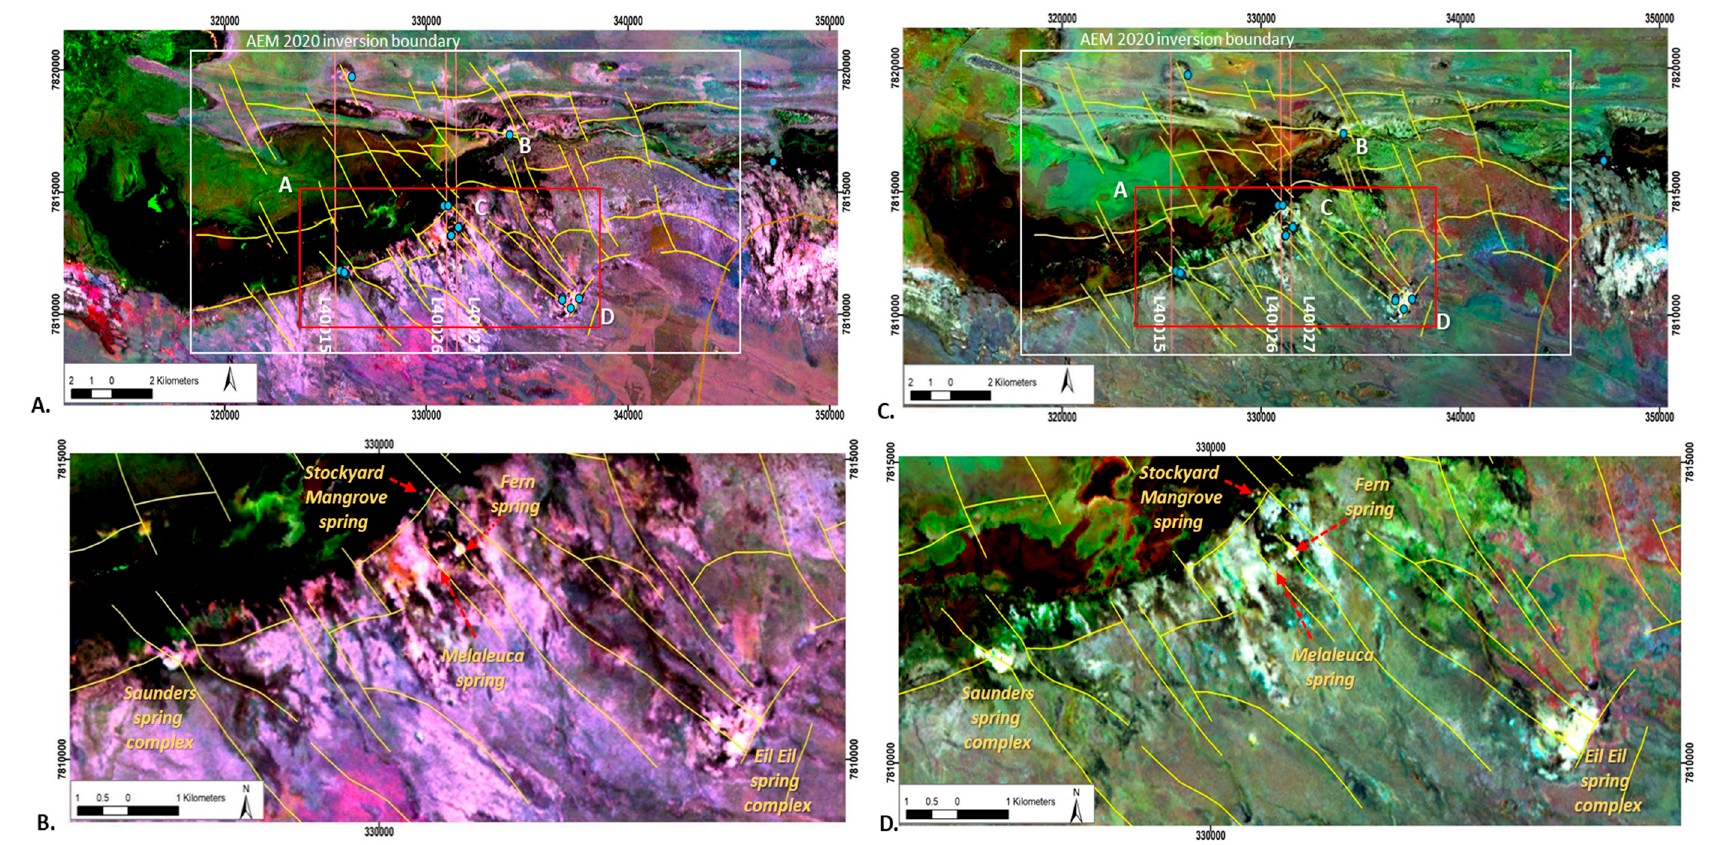
Figure 8. Fractional cover models, fine-scale interpretation of Figure 7: ( A ) Fractional cover model composite image of average annual vegetation for years 1990, 1991 and 1992; spring sampling locations (blue dots); geological faults are yellow lines; flight lines L40015, L40026 and L40027 are orange lines and numbers within maps and A to D represent major interpretation domains discussed in the text. ( B ) Detail within red rectangle in Figure 8A; ( C ) Fractional cover model composite image of average annual vegetation for years 2014, 2015 and 2016, detail as per Figure 8A and ( D ) detail within red rectangle in Figure 8C.